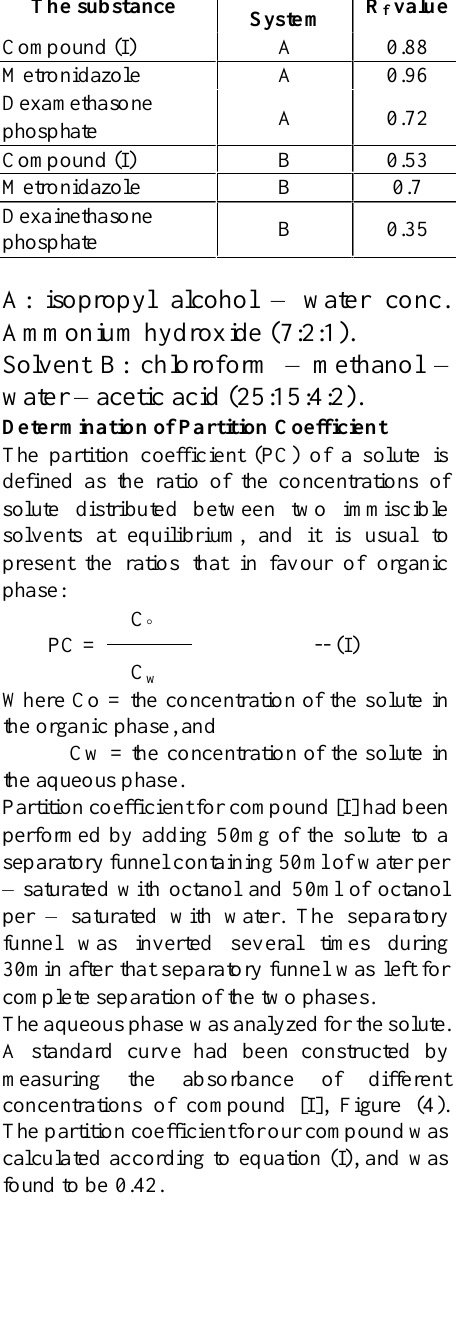
Fig.3 IR Spectrum of Compound I